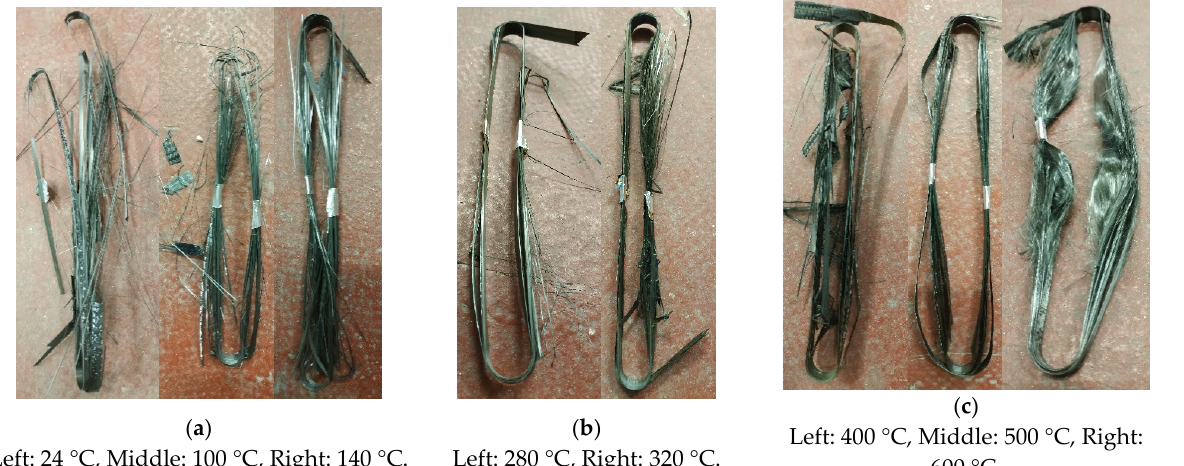
Figure 26. Strap failure modes in SS tests at different temperature levels: ( a ) between 24 and 140 °C, ( b ) at 280 and 320 °C, and ( c ) between 400 and 600 °C.